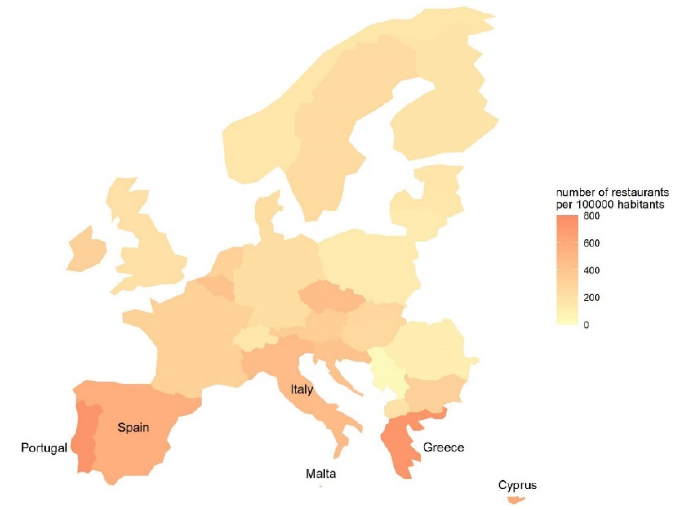
Figure 1. Number of restaurants in Europe per 100,000 habitants. Compiled by the authors using data from Eurostat [38]. The countries with the highest ratios are (i) Portugal (736.40), (ii) Greece (735.32), (iii) Cyprus (601.69), (iv) Spain (557.90), (v) Malta (470.46) and (vi) Italy (468.75).